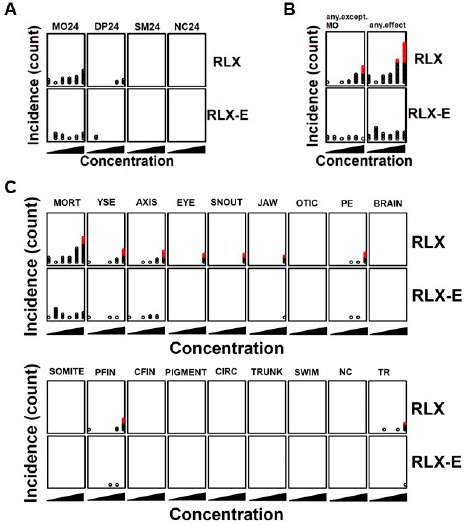
Figure 3. Zebrafish toxicity. ( A – C ) To identify potential in vivo toxicity in the developing animal model, zebrafish embryos were treated with raloxifene or analog E/Y134 (vehicle, 0.5 µM, 1.9 µM, 7.1 µM, 27 µM, and 100 µM) at 5 h post fertilization (hpf). Developmental defects and mortality were assessed at 24 hpf ( A ) and 120 hpf ( B , C ). Each circle corresponds to the affected embryo, and red circles indicate the incidence of statistical significance suggesting toxicity. MO24, mortality at 24 hpf; DP24, developmental progression at 24 hpf; SM24, spontaneous movement at 24 hpf; NC24, notochord at 24 hpf; any except MO, any effect except mortality at 120 hpf; any effect, anything including mortality at 120 hpf; MORT, mortality at 120 hpf; YSE, yolk sac edema at 120 hpf; AXIS, crooked tails at 120 hpf; EYE, eye swelling at 120 hpf; SNOUT, snout malformation at 120 hpf; JAW, jaw malformation at 120 hpf; OTIC, otic vesicle at 120 hpf; PE, pericardial edema at 120 hpf; BRAIN, brain at 120 hpf; SOMITE, somite at 120 hpf; PFIN, pectoral fin at 120 hpf; CFIN, caudal fin at 120 hpf; PIGMENT, pigmentation at 120 hpf; CIRC, circulation at 120 hpf; TRUNK, trunk at 120 hpf; SWIM, swim bladder at 120 hpf; NC, notochord at 120 hpf; TR, touch response at 120 hpf.